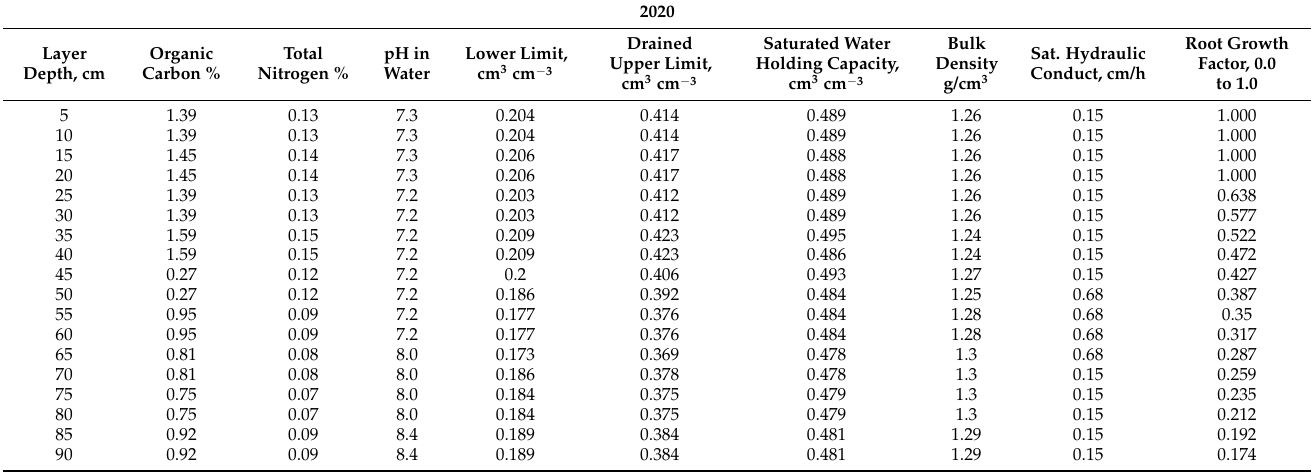
Table 5. The physical and chemical parameters of the soil in the experimental area in